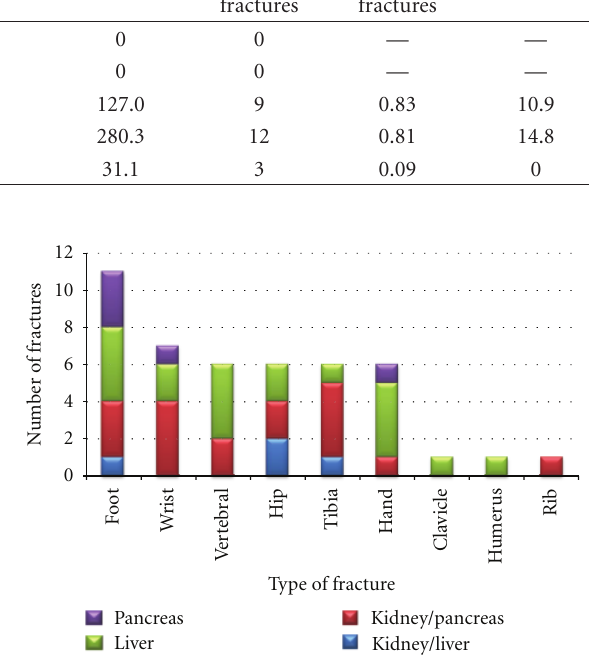
Figure 1: Type of fracture by type of solid-organ transplant.